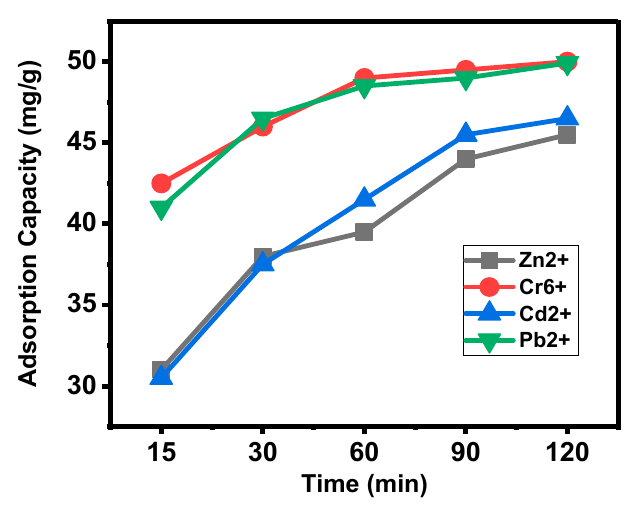
Figure 4. The adsorption capacity (q e ) by the activated carbon at different time points for the metal ions Cr 6 + Pb 2 + , Cd 2 + and Zn 2 + .